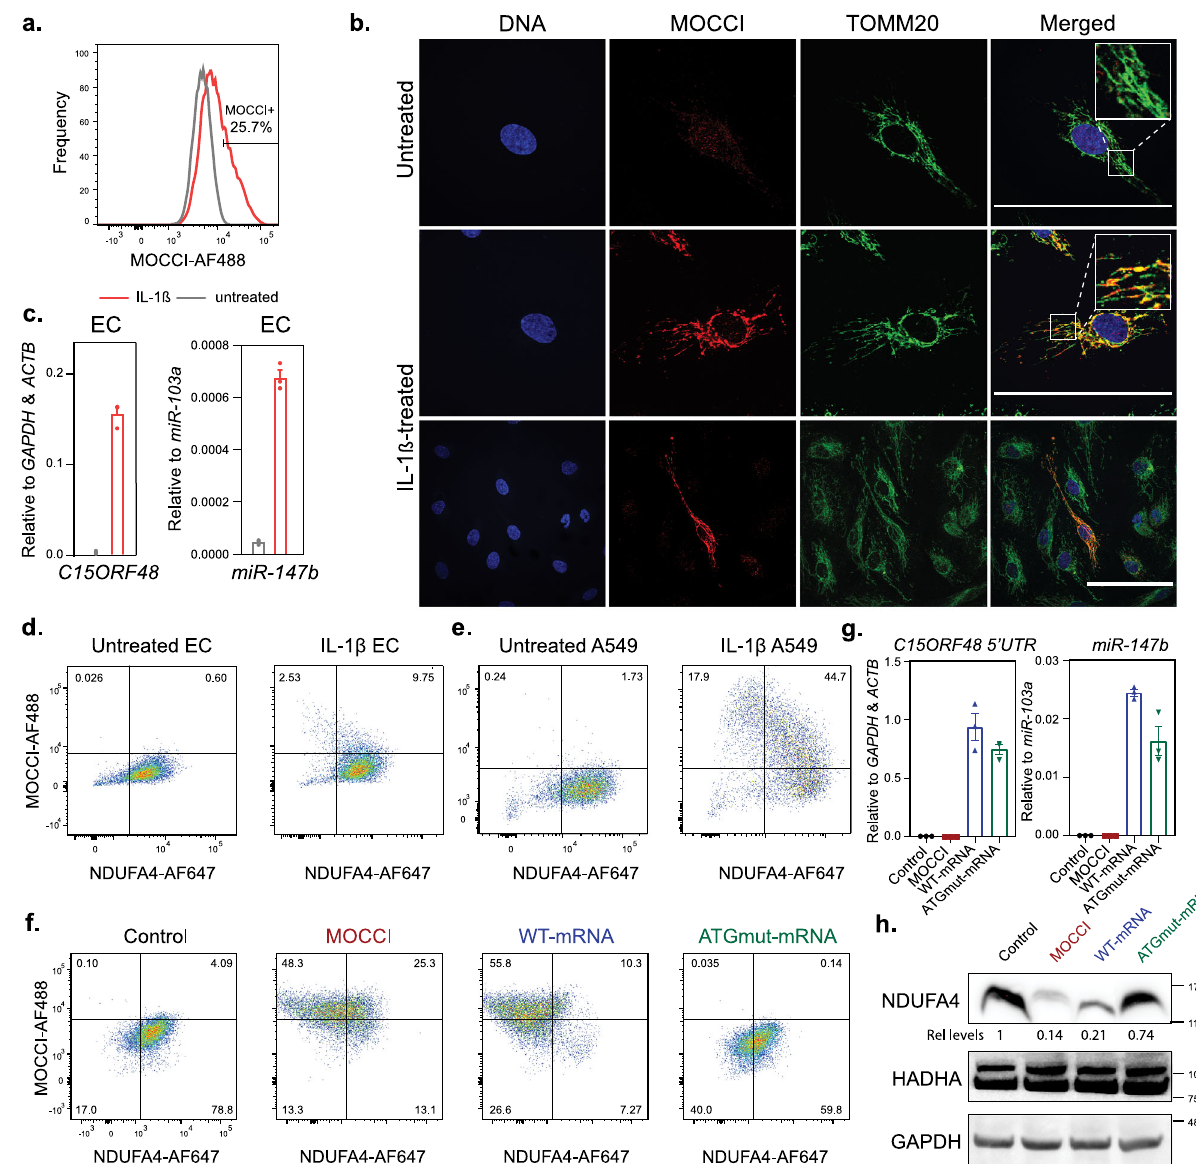
Fig. 3 MOCCI and miR-147b reduce NDUFA4 expression during in fl ammation. a Intracellular fl ow cytometry staining for MOCCI in untreated (gray line) and IL-1 β -treated (red line) human aortic endothelial cells (HAECs). Percentage of MOCCI-positive HAECs is 25.7 ± 5.2% (mean ± se), n = 4 biological replicates per condition. b Co-immuno fl uorescent staining for MOCCI and TOMM20, a mitochondrial protein in HAECs. Scale bar = 100 µ m, n = 3 biological replicates. c C15ORF48 mRNA and miR-147b expression in untreated and IL-1 β -treated HAECs. Data are presented as mean ± SEM, n = 3 biological replicates per condition. d Intracellular fl ow cytometry staining for NDUFA4 and MOCCI in untreated or IL-1 β -treated HAECs. e Intracellular fl ow cytometry staining for NDUFA4 and MOCCI in untreated or IL-1 β -treated A549 cells. f Intracellular fl ow cytometry staining for NDUFA4 and MOCCI in HAECs overexpressing MOCCI, C15ORF48 WT-mRNA (both MOCCI and miR-147b), and C15ORF48 ATGmut-mRNA (only miR-147b), n = 3 biological replicates per condition. g Levels of C15ORF48 mRNA (primers binding to the 5 ′ UTR of C15ORF48 ) or miR-147b by qPCR in HAECs with the indicated overexpression. Data were presented as mean ± SEM, n = 3 biological replicates per condition. h Western blot of NDUFA4 in HAECs with the indicated overexpression. n = 3 biological replicates. Source data are provided as a Source Data fi